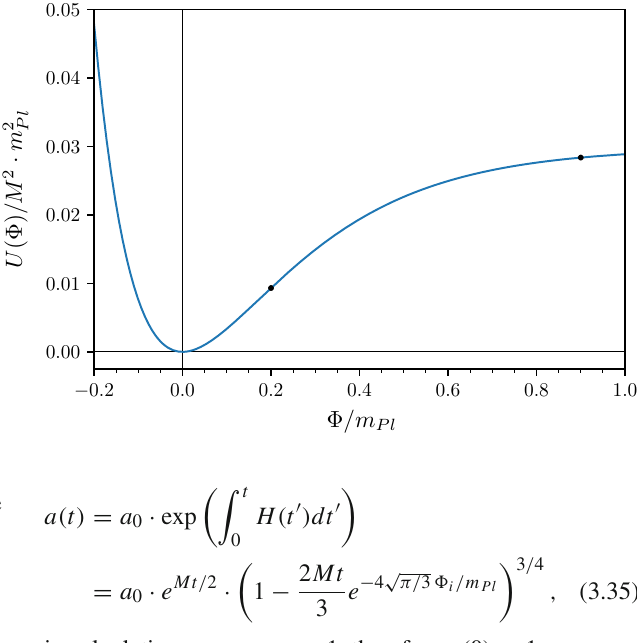
Fig. 6 Inflaton potential U ((cid:9)) in the R 2 -inflation. Black dots correspond to (cid:9) i = 0 . 9 m Pl and